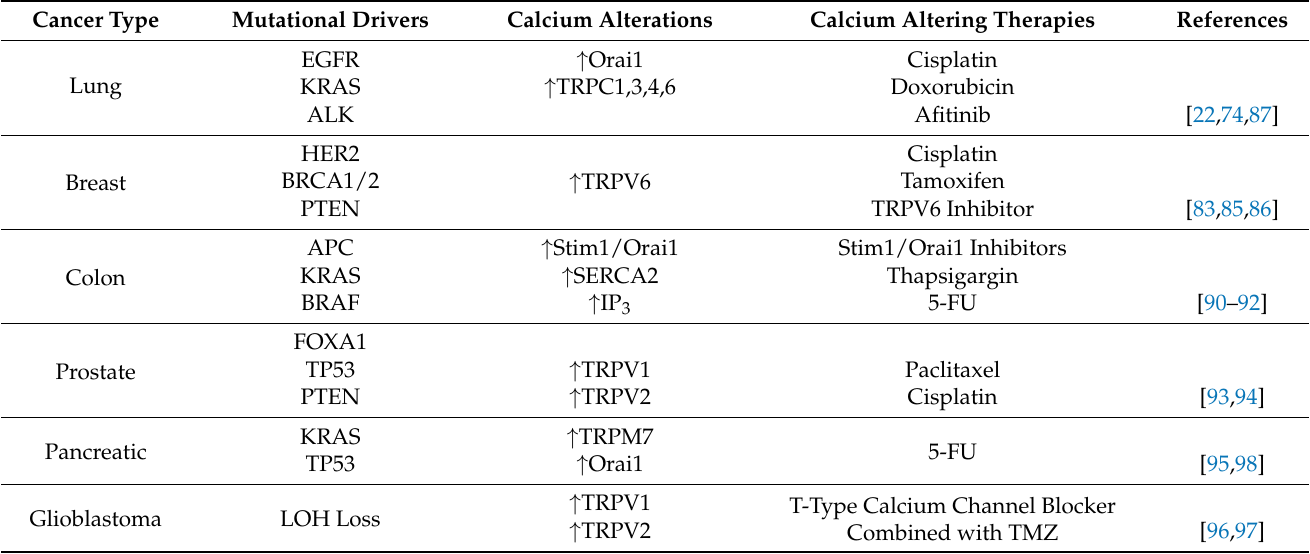
Table 1. Calcium changes by cancer type as a result of therapies targeting calcium